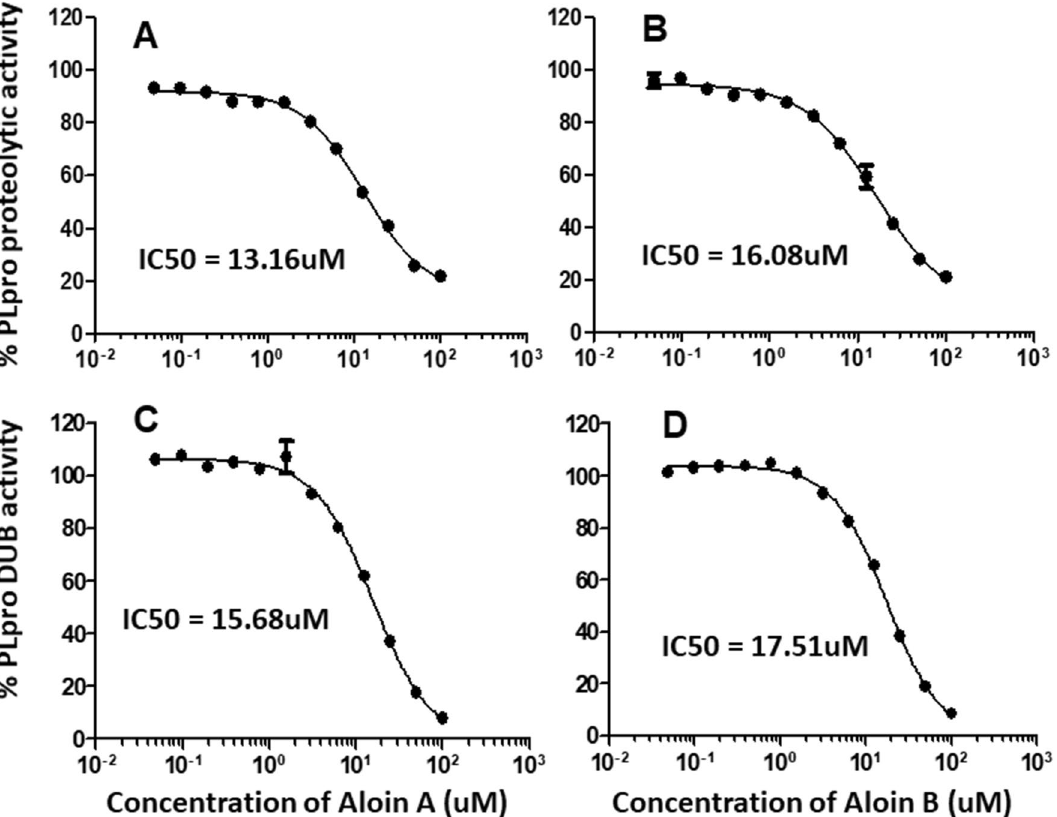
Figure 7. Dose-dependent inhibition of SARS-CoV-2 PLpro proteolytic and DUB activity by aloin A and B. A serial dilution of aloin A and B ranging from 0–100 µM in assay buffer was used. The percent activity was calculated as described in Fig. 2 legend. DMSO (0.1%) with enzyme and 50µM of substrate served as positive control. Wells with 50µM of GRL-0617 compounds served as specificity controls for PLpro. Representative of three individual experiments with triplicate values were presented graphically (n = 3). Non-linear regression (curve fit) with four variable dose vs inhibition was used to calculate the IC 50 values using GraphPad Prism.